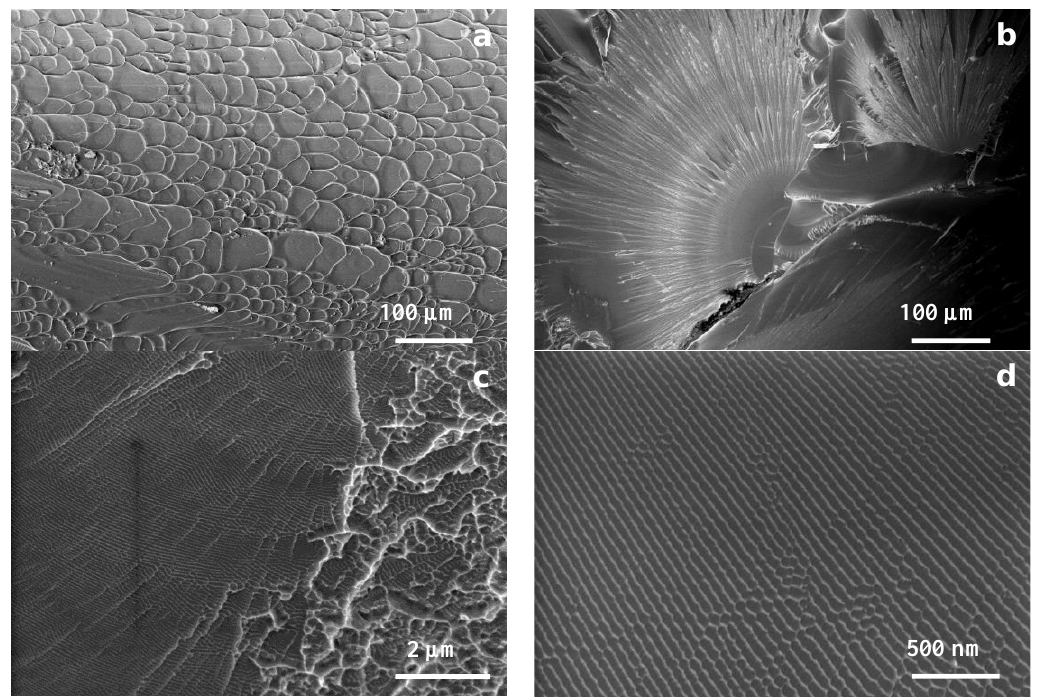
Figure 1. ( a ) An example of shear fracture in a Cu compression, showing vein patterns. ( b ) Brittle fracture in the Fe showing mirror, mist and hackle zones. ( c , d ) Higher magnification views showing nanoscale dimples and corrugations on the fracture surface of Fe